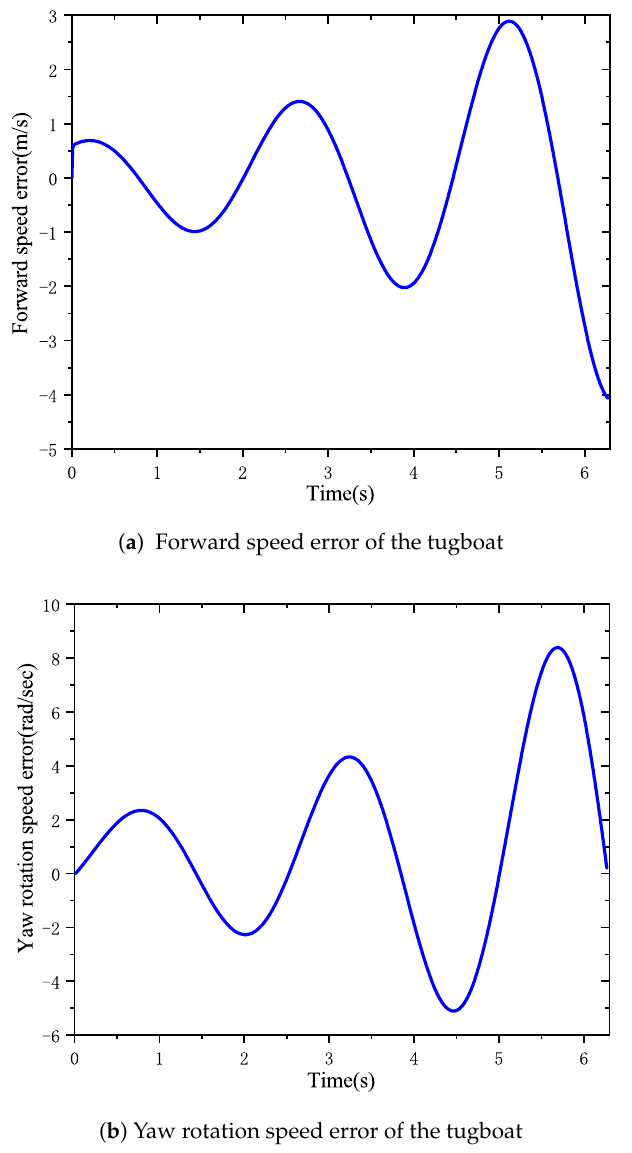
Figure 7. Actual motion speed error of the tugboat under the uncertain factor d ( t )